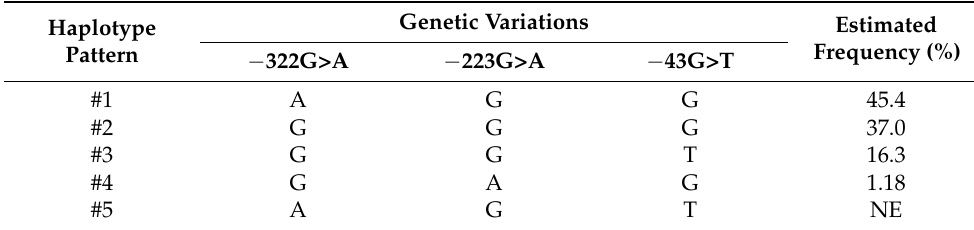
Table 4. Haplotypes of Cathepsin A 5 (cid:48) -FLR.